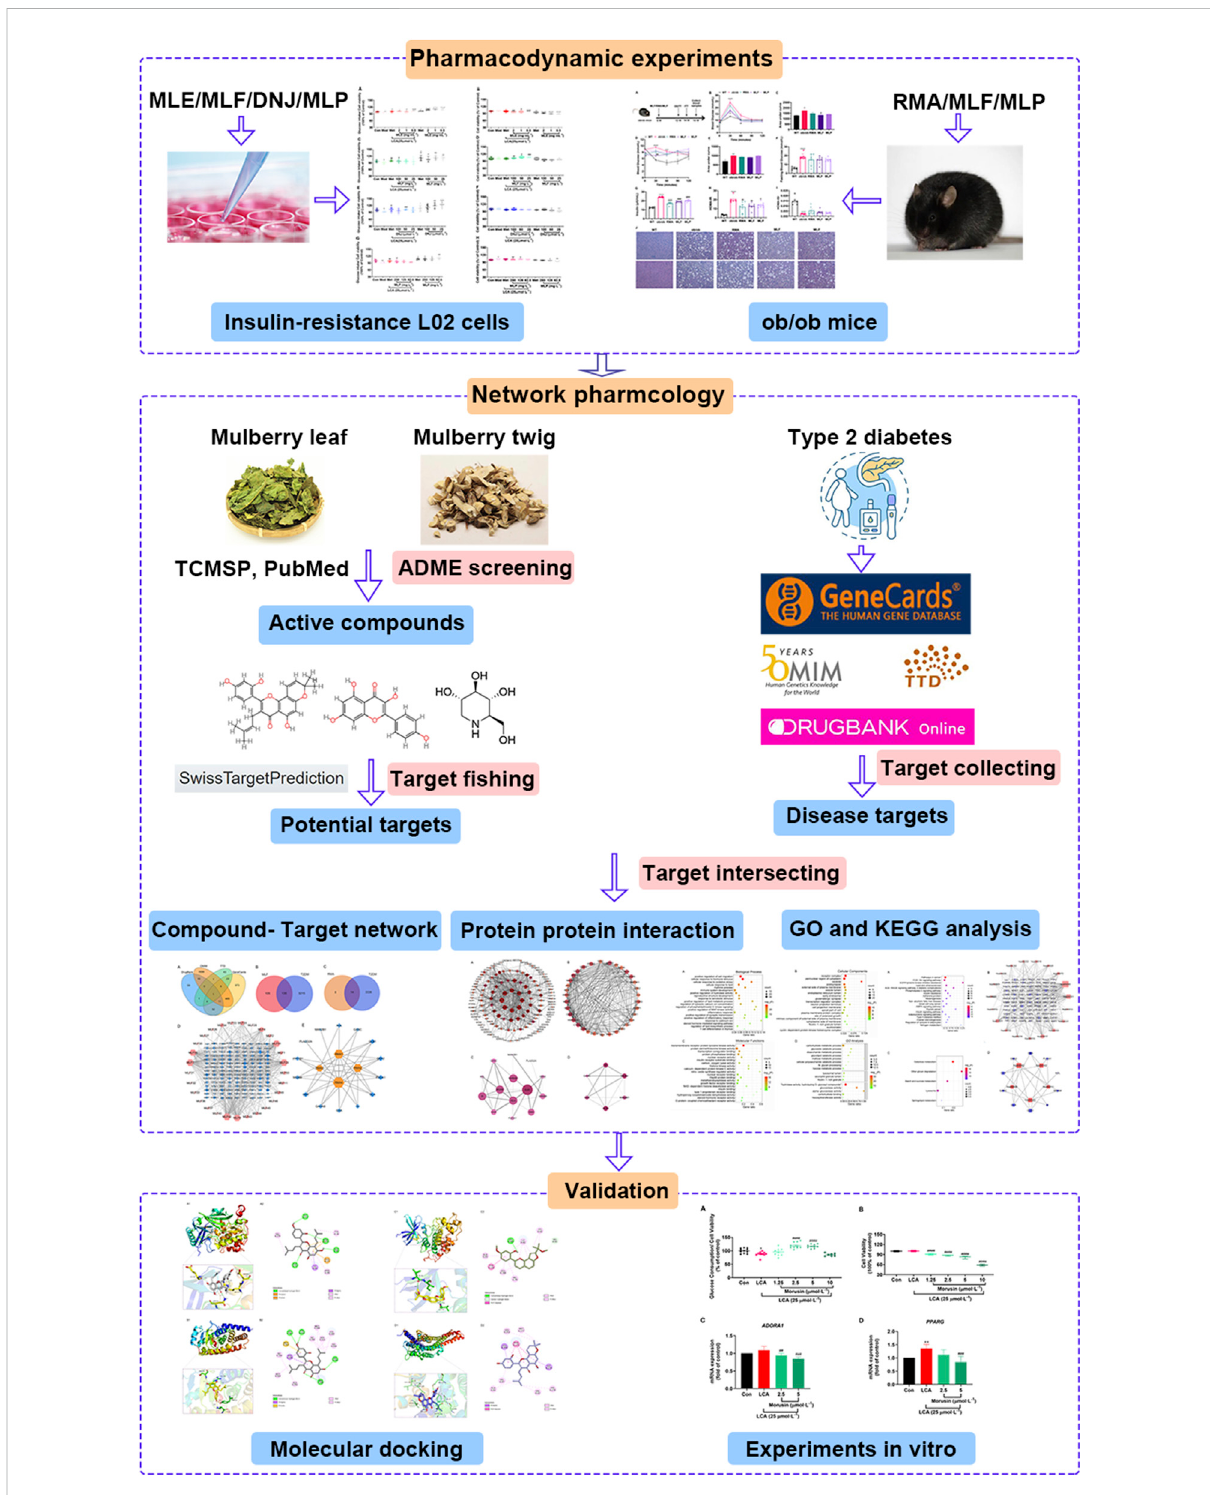
FIGURE 2 Integrated work fl ow for elucidating the active compounds and the underlying hypoglycemic mechanism of mulberry leaves.